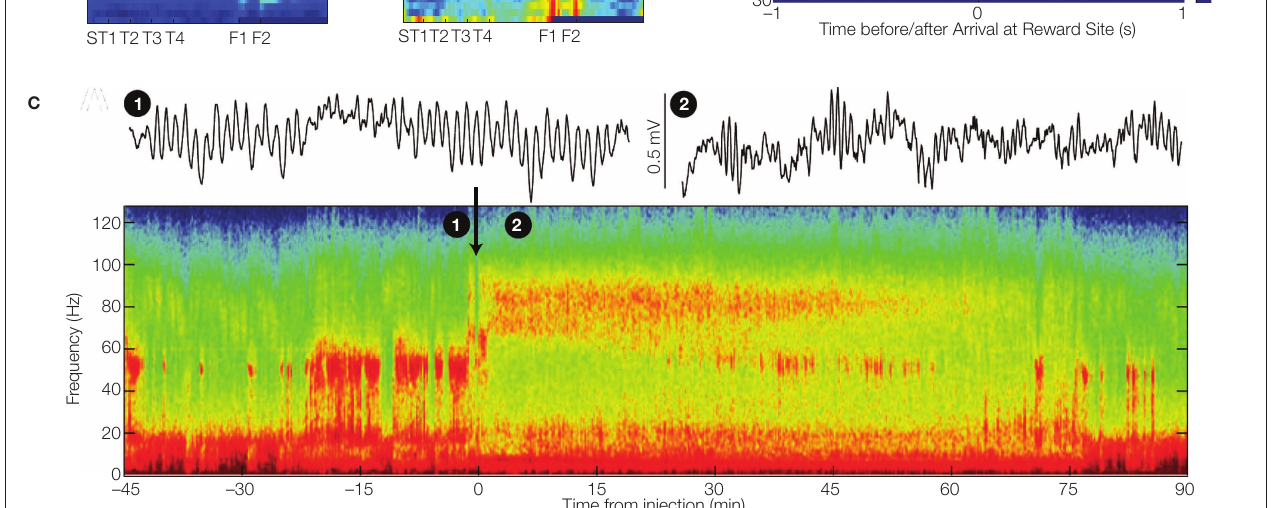
Figure 2 | Three salient properties of ventral striatal gamma oscillations. (A) Gamma-50 (left) and gamma-80 power (right) were distributed differently over a track where rats ran for food reward (provided at reward sites F1 and F2). Gamma-80 ramped up to the reward sites, while gamma-50 increased abruptly. Plot shows average across four subjects; because rats ran a lap-based task, data were linearized for display (see Figure 4 for task details). Data from van der Meer and Redish (2009b). (B) Example session in which gamma power